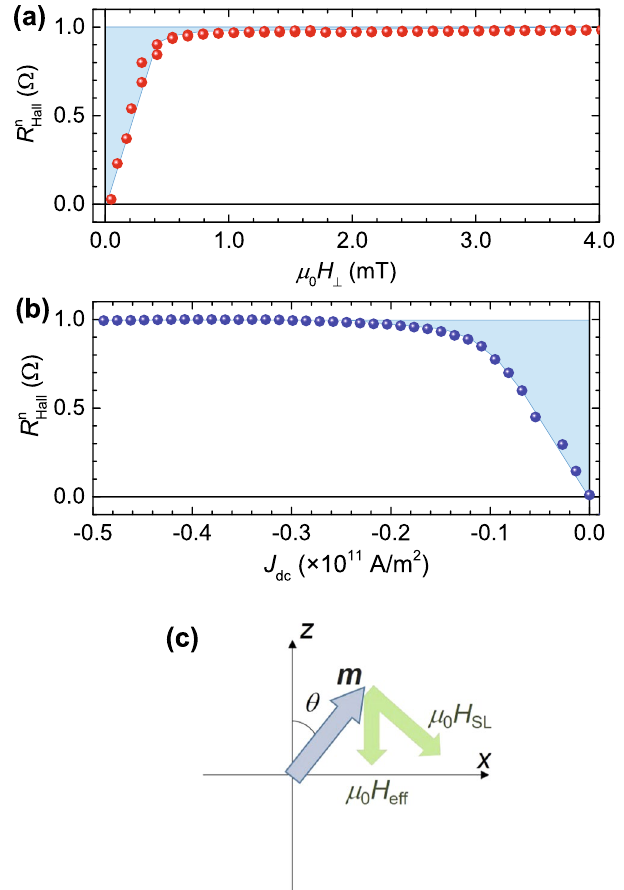
Figure 4. Quantitative determination of SOT effective field. ( a ) Normalized R Hall as a function of μ 0 H z in range from 0 to + 4.0 mT at 343 K. ( b ) Negative J dc dependence of normalized R Hall under μ 0 H x of + 38 mT at 343 K. Zeeman energy gains by μ 0 H z and perpendicular component of the SOT effective field μ 0 H eff correspond to areas of coloured region indicated in a and b, respectively. The error bar, which is the standard deviation of two data points, is smaller than the symbols. ( c ) Schematic illustration displaying directions of the longitudinal effective field due to the Slonczewski-like torque μ 0 H SL and μ 0 H eff with respect to the magnetization direction m . Electrical current flows in + x